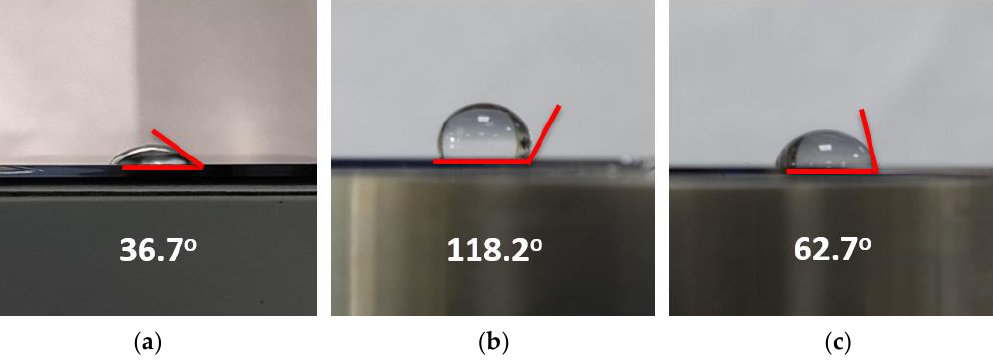
Figure 5. Water contact angle measurement for ( a ) bare silicon substrate, ( b ) silicon substrate deposited by OTS, and ( c ) silicon substrate after C-beam irradiation using 88-island emitter array of VACNTs.